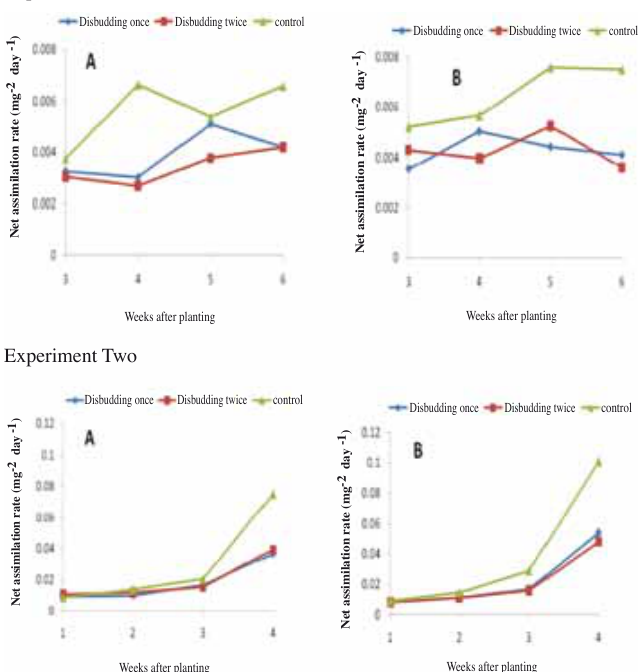
Fig. 6 - Net assimilation rate as affected by disbudding and cultivar: ‘Carmine’ (A) and ‘Chief Gold’ (B).